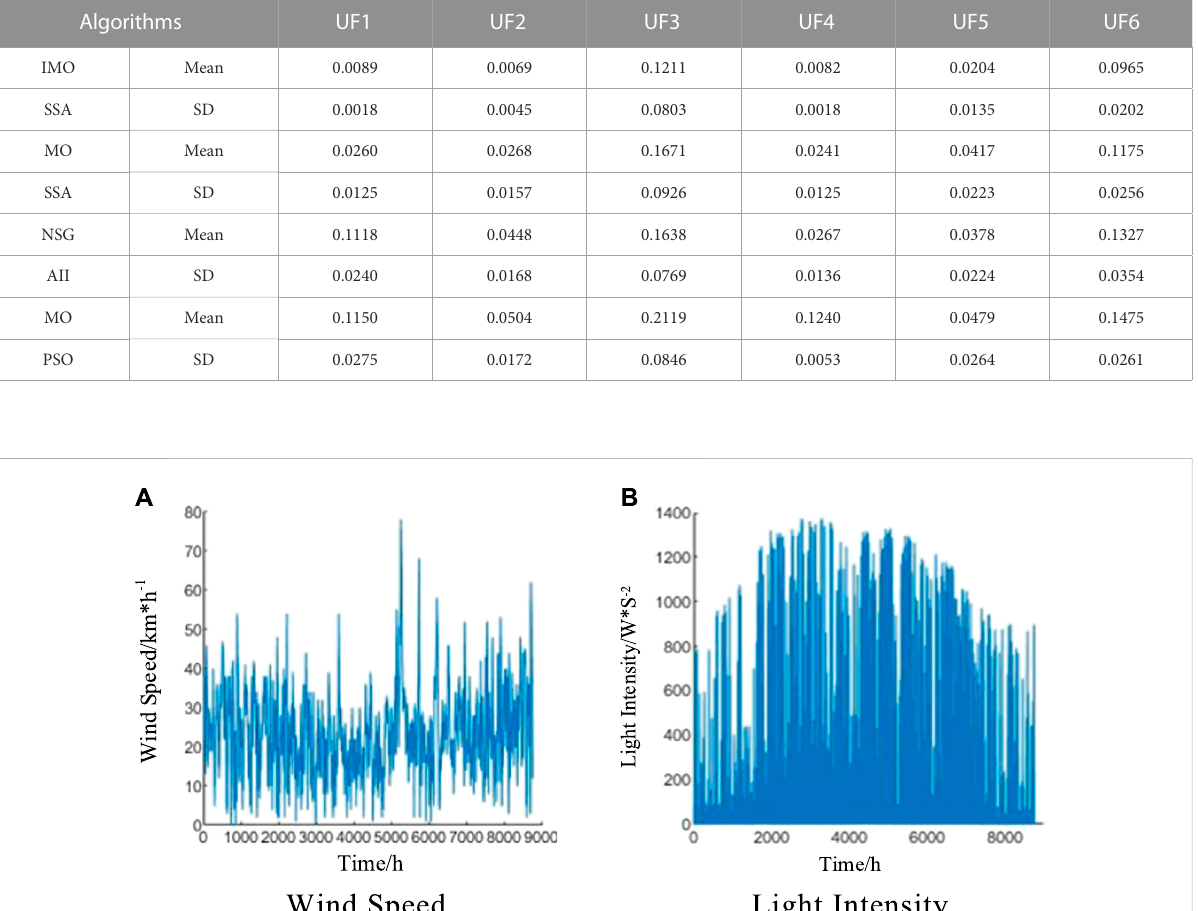
TABLE 1 Test results of four algorithms on test function.